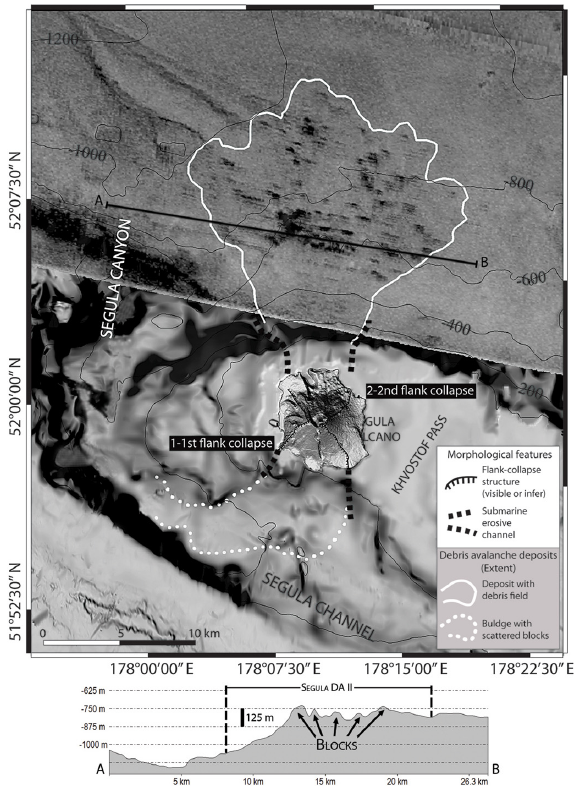
Fig. 4. Topography, bathymetry and Gloria side-scan data of Segula volcano and its northern submarine slopes. A transversal profile is reported showing the lenticular shape of the deposit and the pres- ence of large blocks. The image displays the speckled pattern char- acteristic of large debris slide deposits on the north side. For side scan data the black is high backscatter and white is low backscatter. Contour interval is 200m.